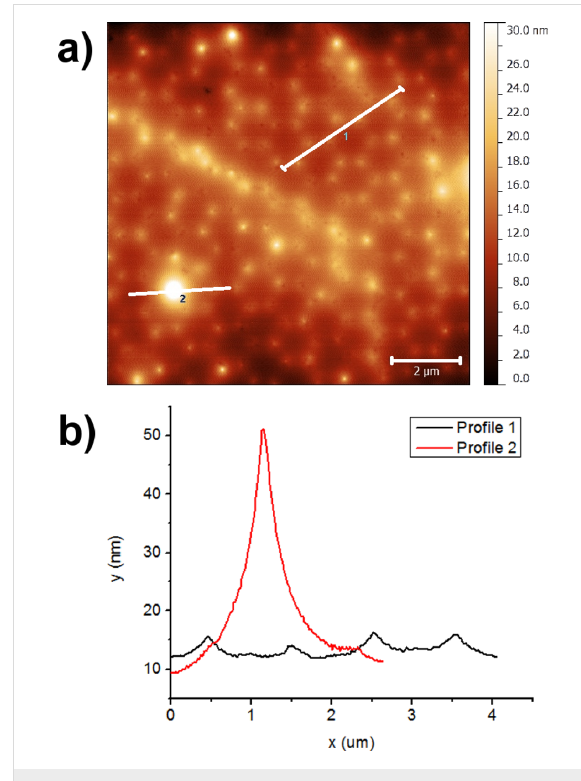
Figure 20: (a) AFM image of Ag nanoantennas spin coated with VTLUNP (b) AFM height profiles along the lines 1 and 2 marked in